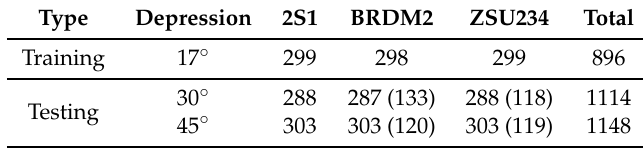
Figure 10. Examples of BRDM2 and ZSU234 with depression and articulated variants: ( a , b ) display SAR images of BRDM2 collected at 30 ◦ and 45 ◦ with hatch variation; and ( c , d ) display SAR images collected at 30 ◦ and 45 ◦ with gun turret variation. Table 5. The number of images for large depression and articulation